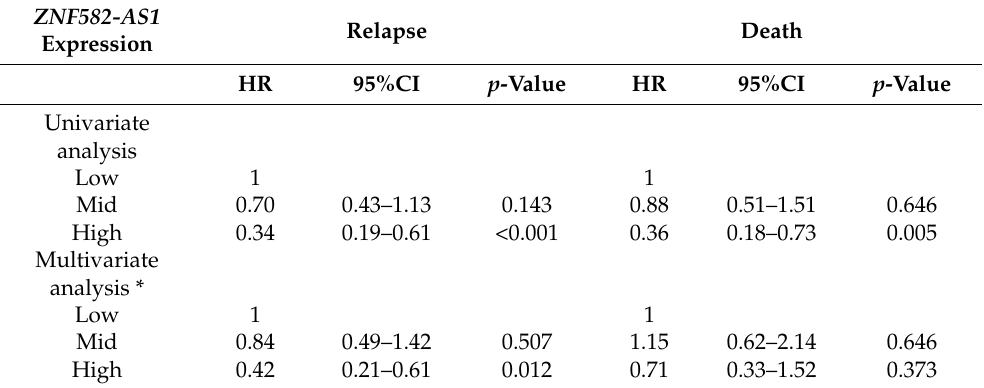
Table 2. Associations between ZNF582-AS1 expression and risk of breast cancer relapse or death.